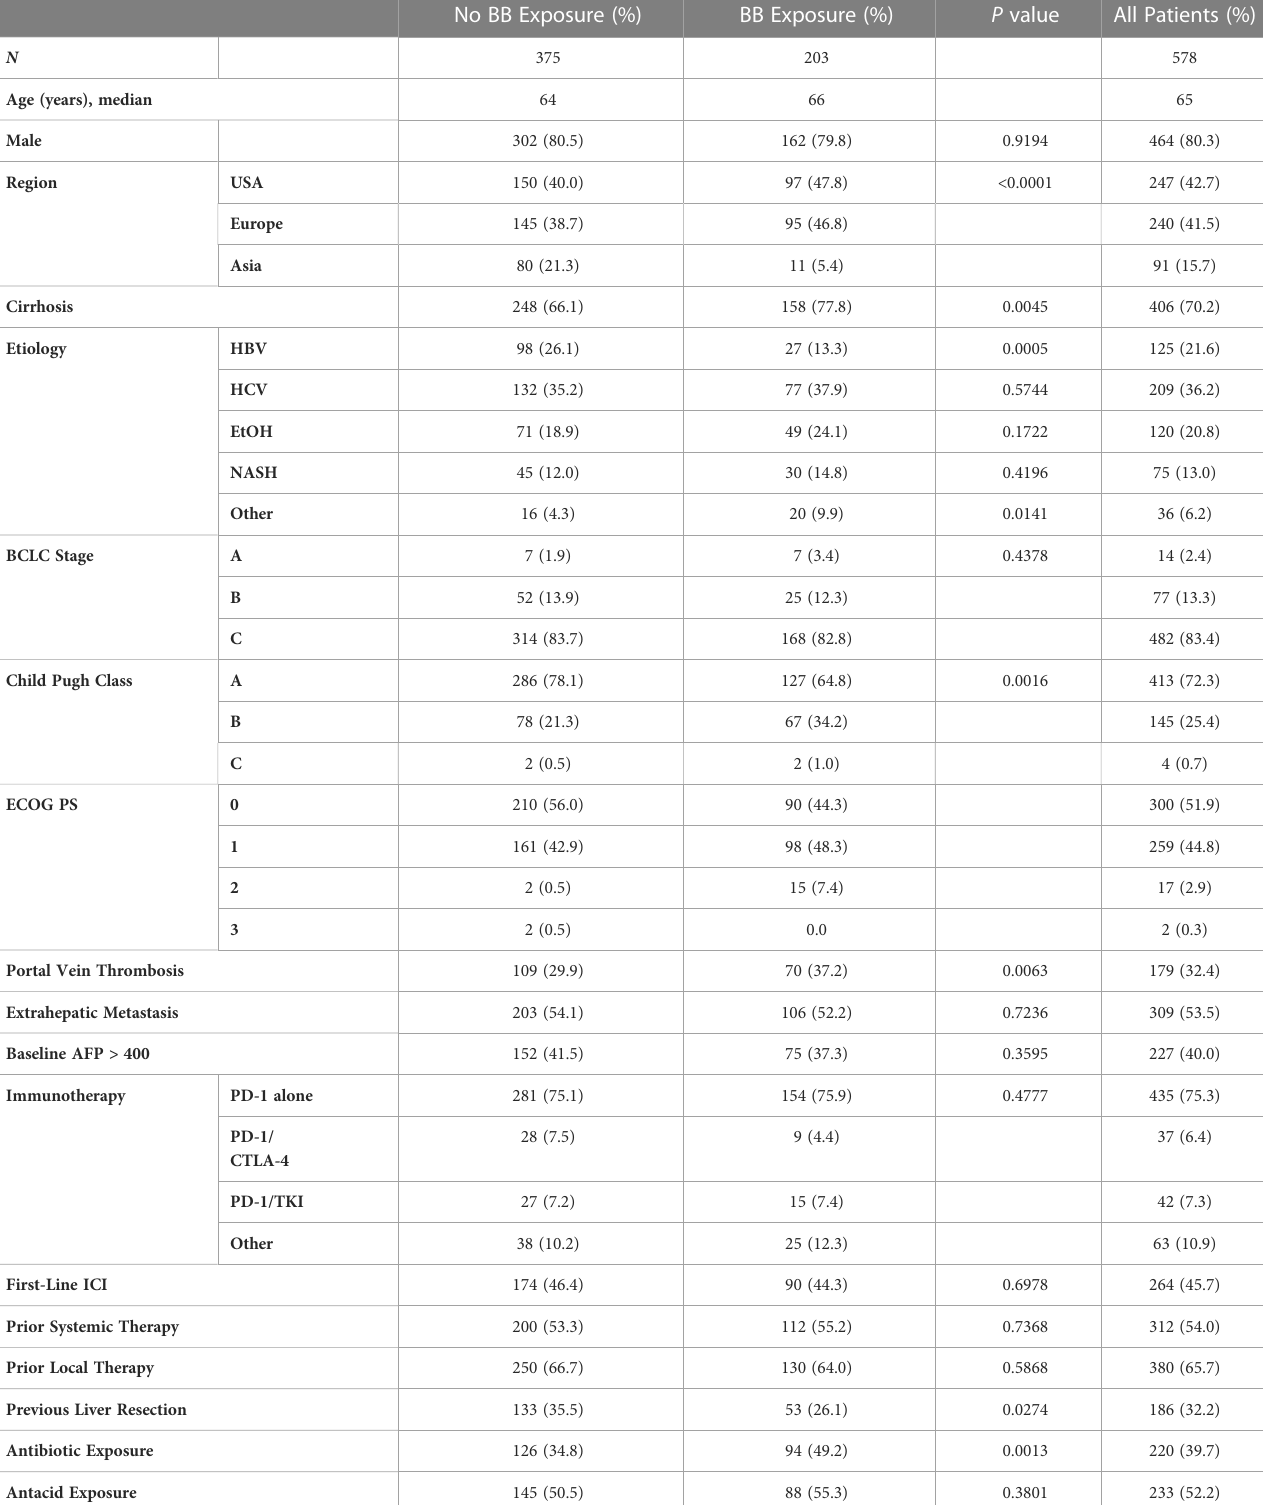
TABLE 1 Baseline characteristics by beta blocker